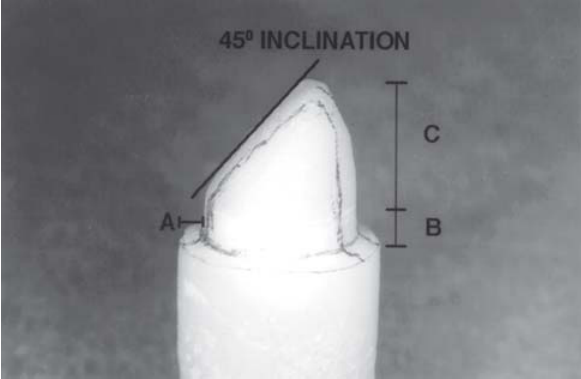
FIGURE 4- Specimen positioned in the cyclic machine for fatigue test. A- Aluminum block; B- Acrylic box containing distilled water surrounding the specimen and C- Mechanical device containing the sphere placed on the crown lingual surface